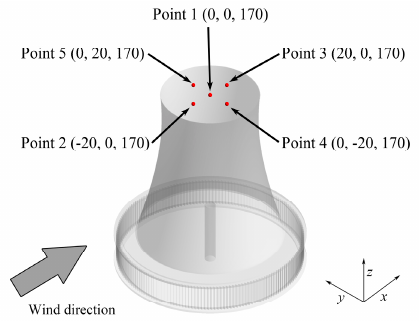
Figure 15. Schematic diagram of monitoring point location.